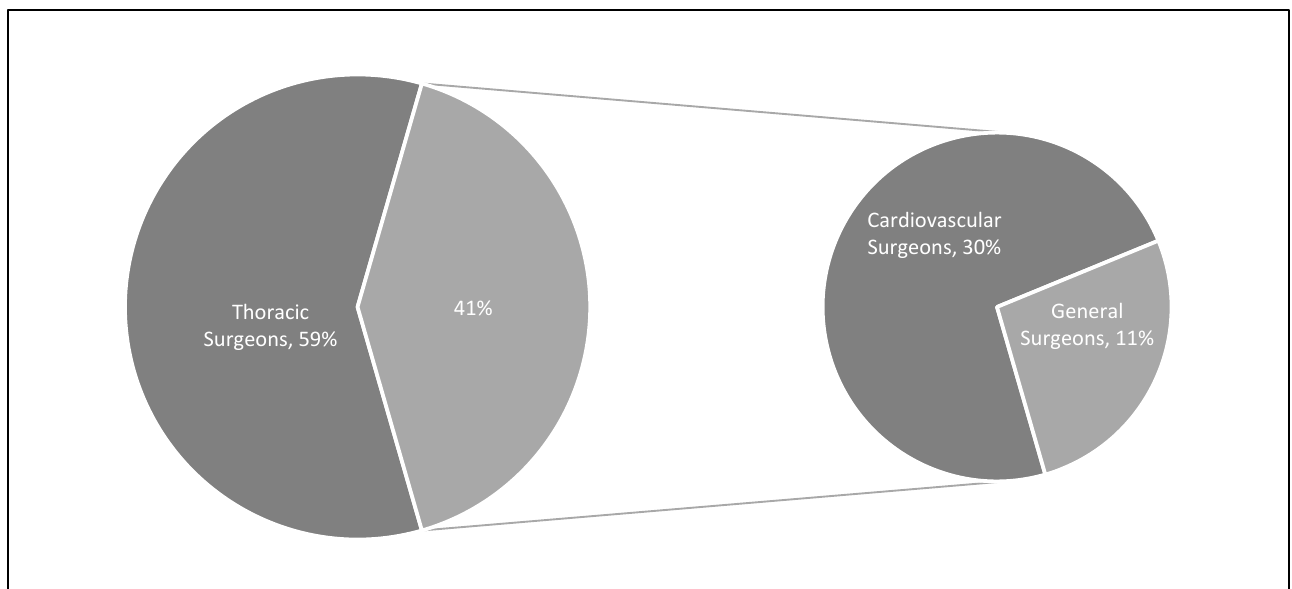
Figure 1. Overall percentage of lung lobectomies performed by each provider type in the Premier Healthcare Database from 2009 to 2019.